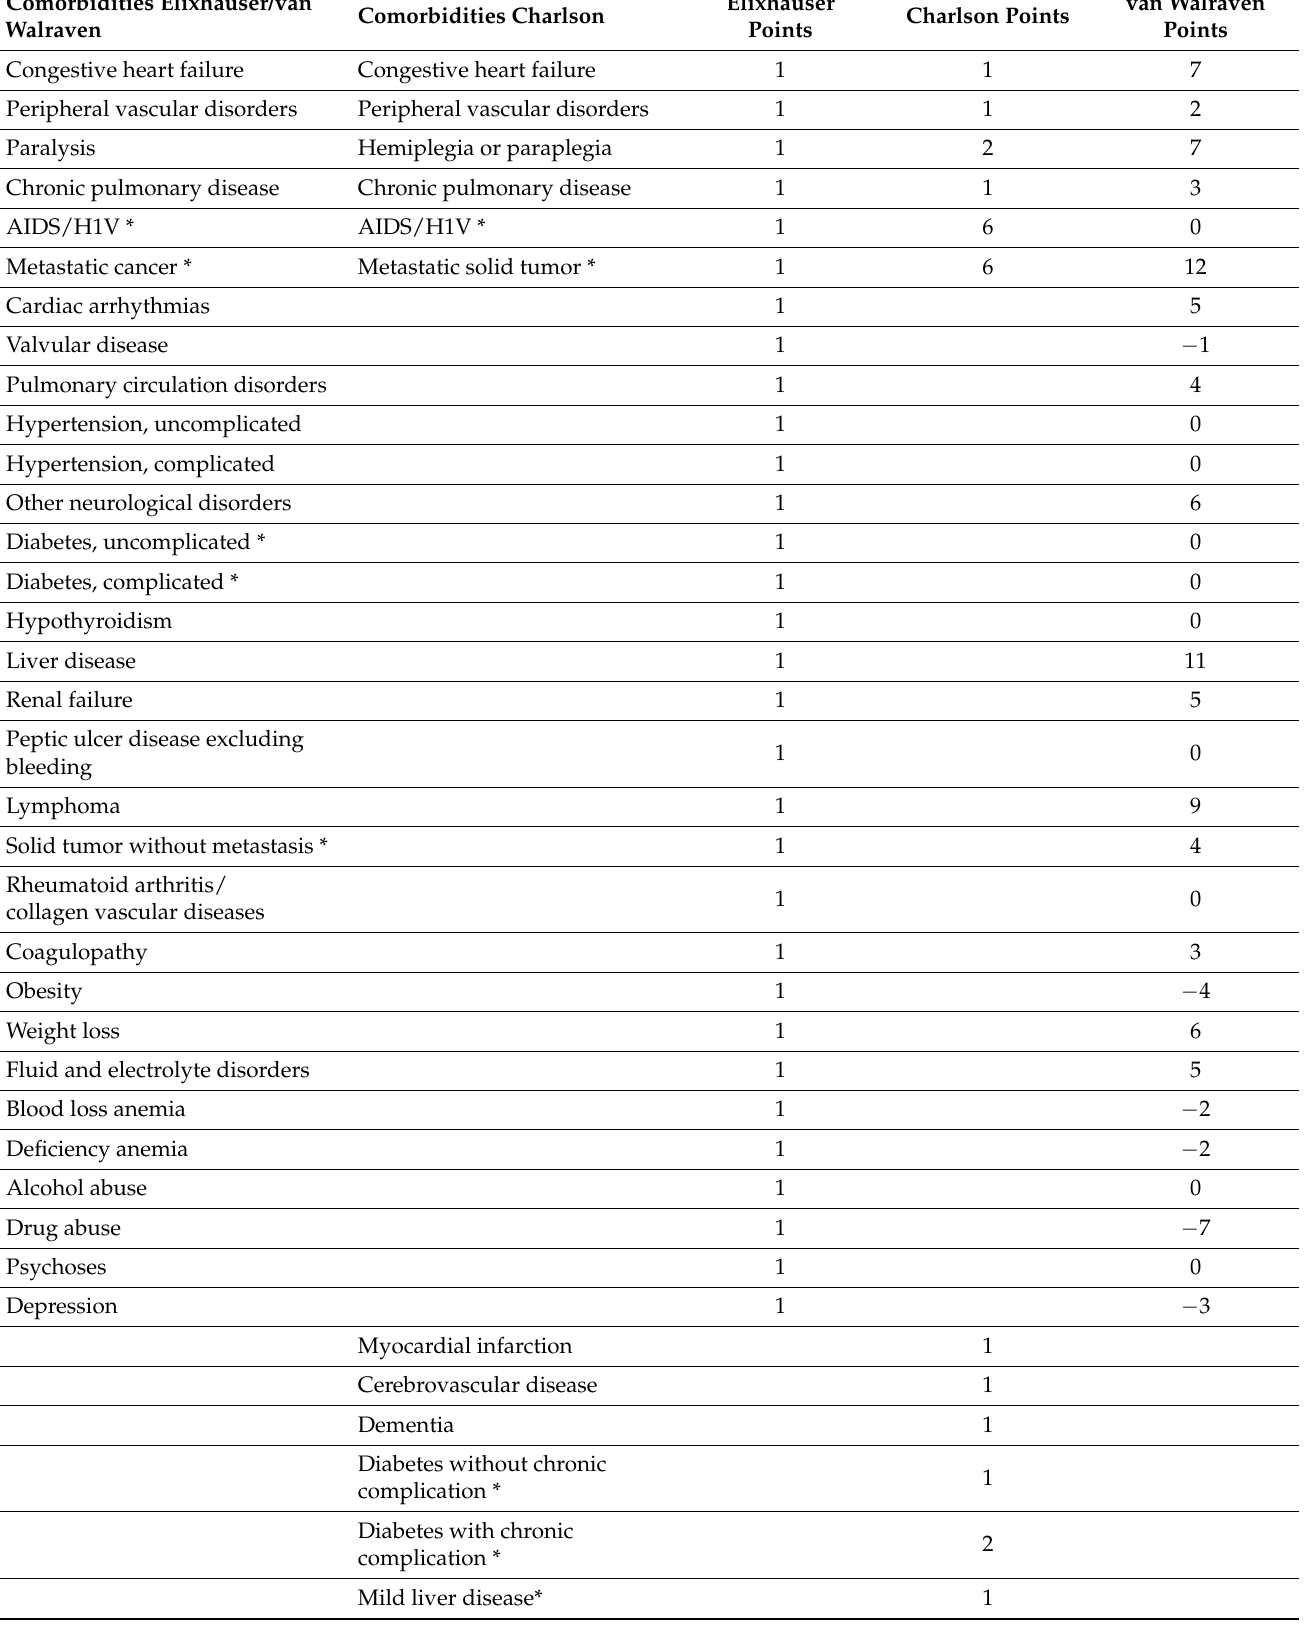
Table A2. Elixhauser, Charlson and van Walraven comorbidities